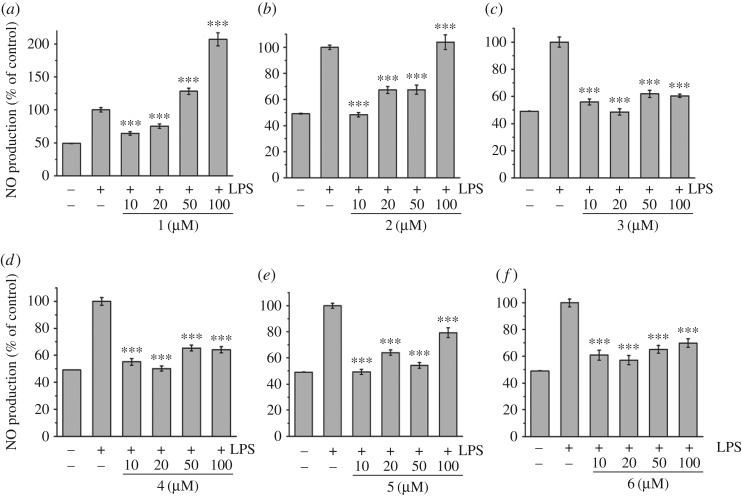
Effects of complexes 1–6 on NO production in LPS-induced RAW 264.7 cells. NO production was measured by the Griess reaction assay and expressed as a percentage of the positive control (LPS alone ‘+ −’). The negative control ‘−−’ looks at the NO production for cells untreated with LPS or any complex. Values are the mean + s.d. of at least three independent experiments. Detailed data are included in the electronic supplementary material. All statistical analyses refer to the positive control (LPS alone ‘+ −’). *p < 0.05, **p < 0.01, ***p < 0.001.